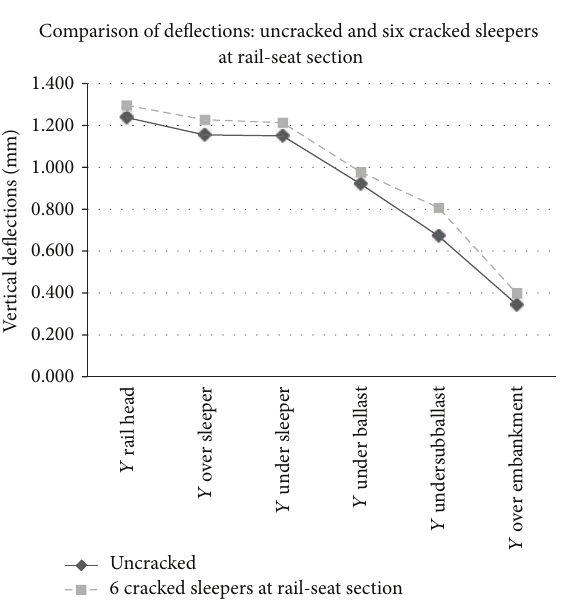
Figure 6: Comparison of deflections (mm) in a track with healthy sleepers and six cracked sleepers at rail-seat